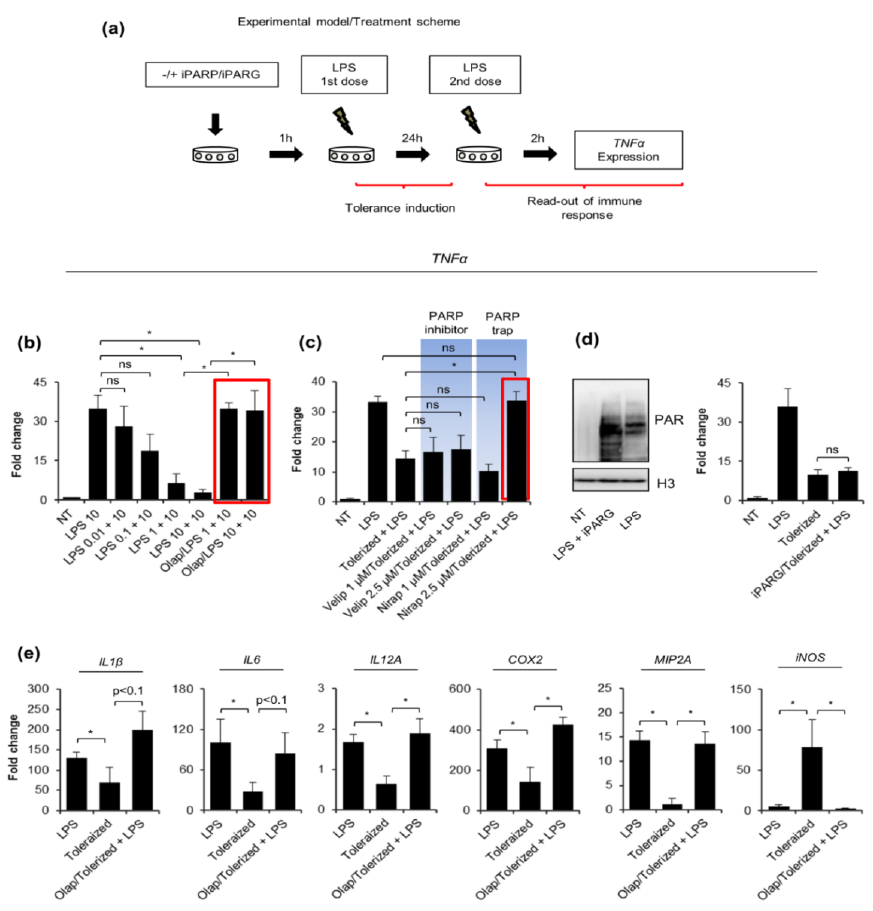
Figure 1. PARP traps maintain proinflammatory response in human macrophages activated with tolerance-inducing LPS doses. ( a ) The scheme of tolerance induction presents an experimental approach and cell treatments: the first dose of LPS aims to induce cell paralysis or priming within 24 h, the second serves to check macrophage pro-inflammatory response using mRNA of TNF- α as a readout after cell stimulation for 2 h. To test a possible effect of the key enzymes involved in the ADP-ribosylation metabolism (PARP inhibitors: olaparib, veliparib, niraparib, and PARG inhibitor: ADP–HPD) on the tolerance development, the corresponding compounds were added for 1 h prior to the tolerance-inducing (first) dose of bacterial endotoxin. Expression of TNF- α was quantified by real-time PCR, normalized to median of ACTB and GAPDH, and shown as a fold change with respect to control cells (LPS untreated = 1). ( b ) Three doses of LPS were tested for macrophage paralysis and the immunomodulatory effect of PARP inhibitor—olaparib (1 µ M) was estimated based on the TNF- α transcription. The red rectangular indicates the couple: olaparib-LPS that was chosen for further experiments. ( c ) The other two PARP inhibitors, which differ in PARP-DNA binding ability—niraparib (MK-4827) and veliparib (ABT-888), as well as ( d – e ) PARG inhibitor—ADP–HPD (10 µ M) were analyzed for their possible effect on the induction of tolerance by LPS. ( d ) The increased accumulation of ADP-ribosylated proteins caused by ADP–HPD pretreatment of LPS-induced macrophages was confirmed by western blot. H3 was used as a loading control. Full-length western blot images are included in the Supplementary Figure S3. ( e ) The possible modulatory role of PARP1 in the paralysis of macrophage pro-inflammatory phenotype was tested also for other cytokine genes, such as IL-1 β , IL-6, IL-12, MIP2A, COX2, and iNOS using real-time PCR for the measurement of mRNA levels. Bars in the figures represent mean ± standard error of the mean (SEM). One-way analysis of variance (ANOVA1) was carried out in GraphPad Prism 5 to compare means in several groups. Once the significance was detected, ANOVA1 was followed by the Tukey post-hoc test and significant differences between the two considered means are marked with * when significant at p < 0.05, ns—non-significant at p > 0.05. Abbreviations: iPARP—poly(ADP-ribose) polymerase (PARP) inhibitor(s), iPARG—poly(ADP-ribose)